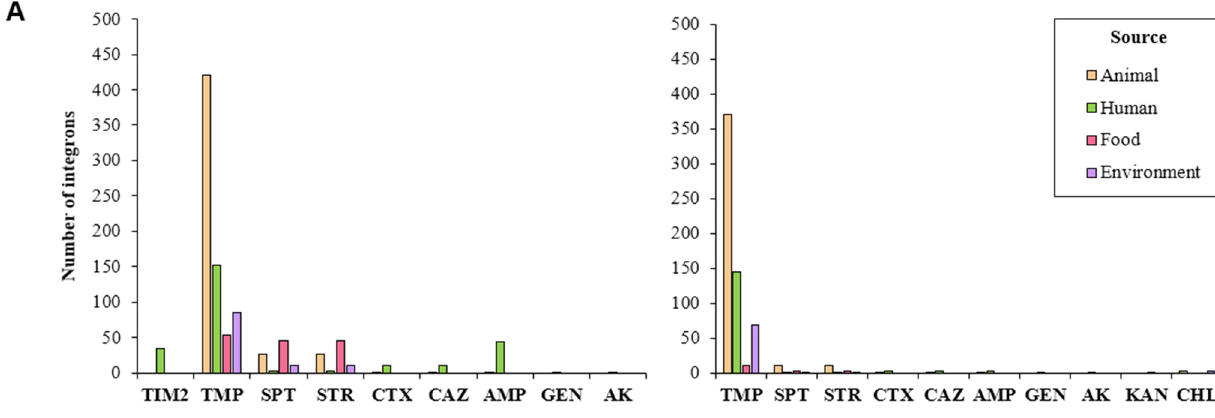
Figure 6. Number of integrons associated with antimicrobial resistance genes, organized by ( A ) source and ( B ) country. SPT, spectinomycin; STR, streptomycin; TMP, trimethoprim; AMP, ampicillin; CTX, cefotaxime; CAZ, ceftazidime; TIM2, ticarcillin/clavulanic acid; GEN, gentamicin; AK; akamicin; KAN; kanamycin. According to IntFinder 1.0, eight different gene cassettes were detected among the identified integrons. Genes encoding for dihydrofolate reductases ( dfr ), which bestow re- sistance to trimethoprim, were present in most of the cassettes. Genes conferring re- sistance to aminoglycosides, β -lactams, and cephalosporins were also identified (Table 1). Table 1. Antimicrobial resistance genes detected among integrons identified in whole-genome sequenced isolates of Sal- monella enterica from countries of the Andean Community according to IntFinder 1.0. Integrase